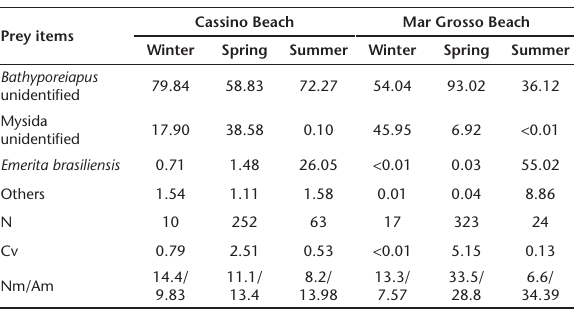
Table 2. Variations in Index of Relative Importance of the main items ingested by the juvenile flatfish of the Cassino and Mar Grosso beaches, during a year. Non-empty stomachs (N), Coef- ficient of Vacuity (Cv), mean number and area (mm 3 ) of preys (Nm/Am). Do not have any individual collected in Autumn. Prey